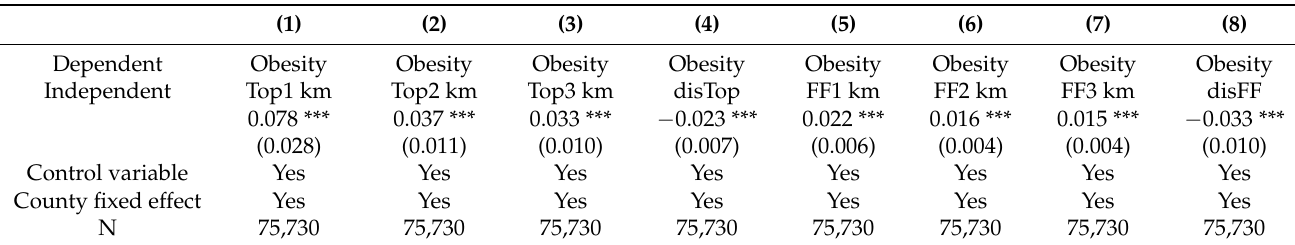
Table 3. Results of 2SLS.